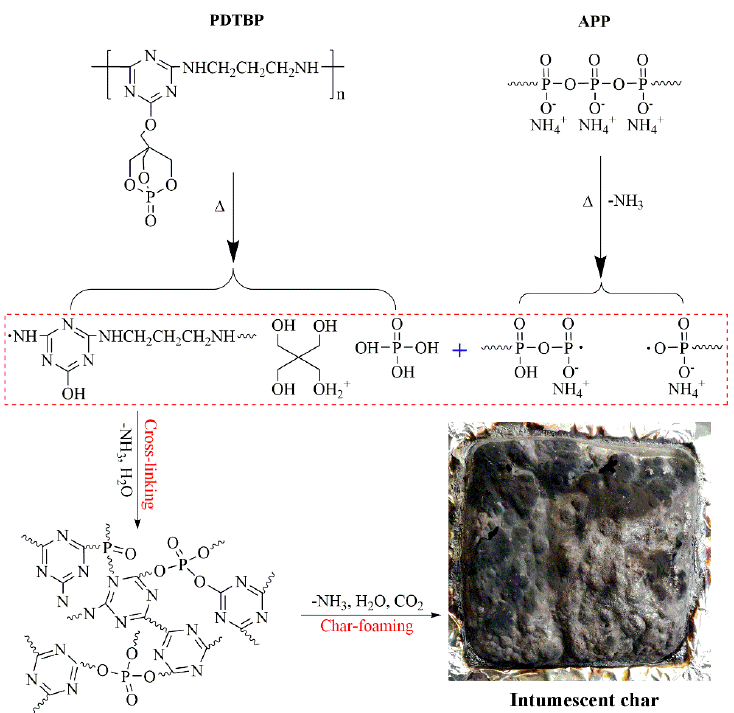
Figure 13. Possible flame-retardant mechanism of APP/PDTBP IFR system for HDPE.